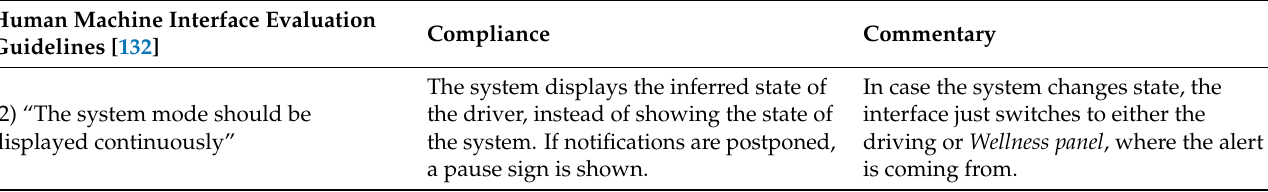
Table 1. System evaluation for compliance with HMI guidelines for automated vehicles, as proposed in [132]. Human Machine Interface Evaluation Guidelines